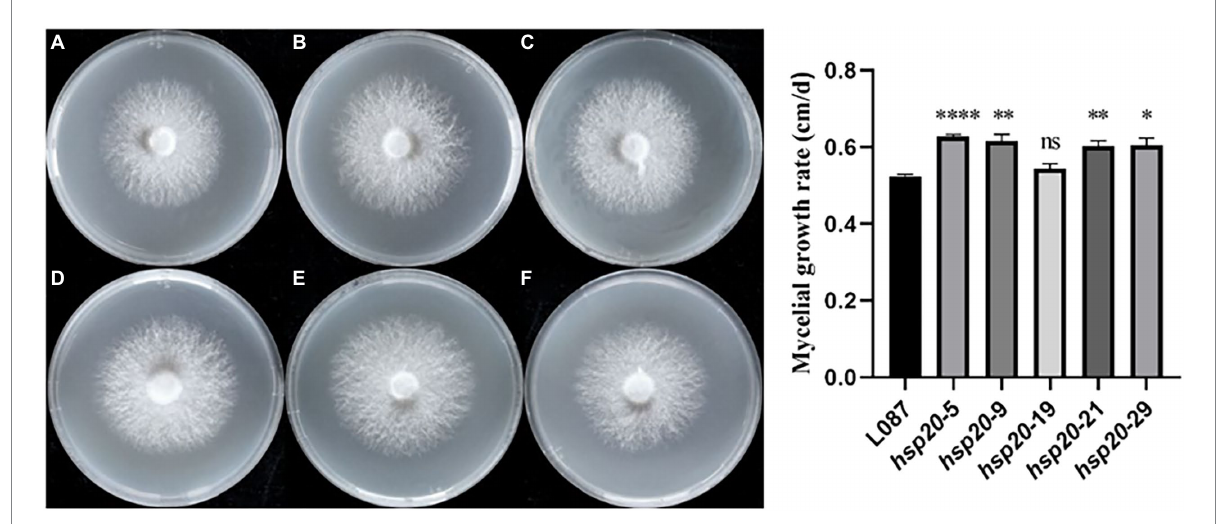
FIGURE 10 The growth of transformants on PDA media and growth rate. (A) L087, (B) hsp20-5, (C) hsp20-9, (D) hsp20-19, (E) hsp20-21, and (F) hsp20-29.